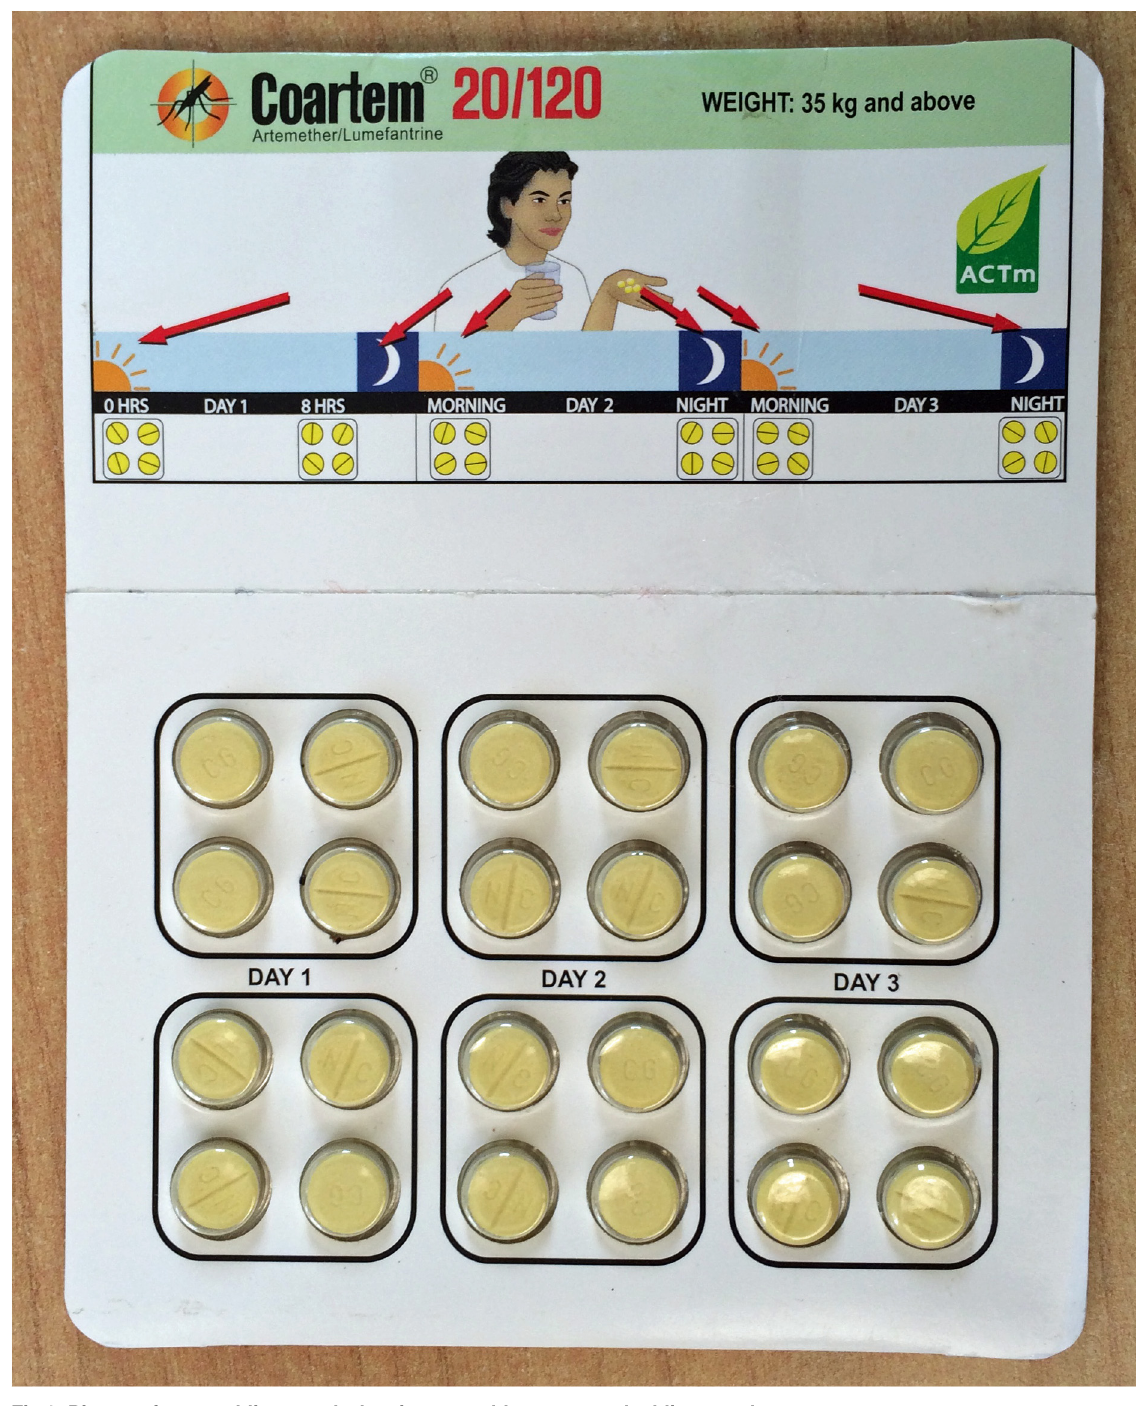
Fig 1. Picture of a smart blister pack showing resemblance to regular blister packs.